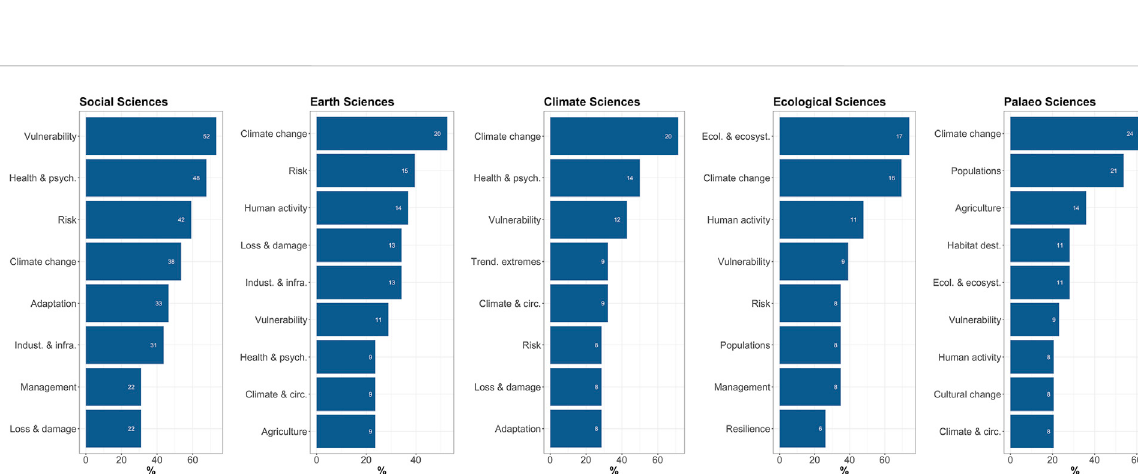
Frontiers in Earth